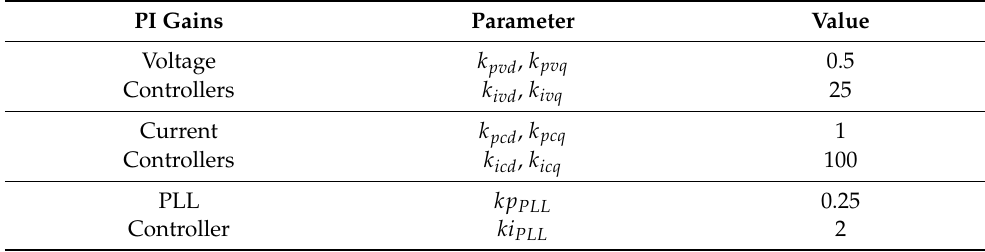
Table 2. Controller